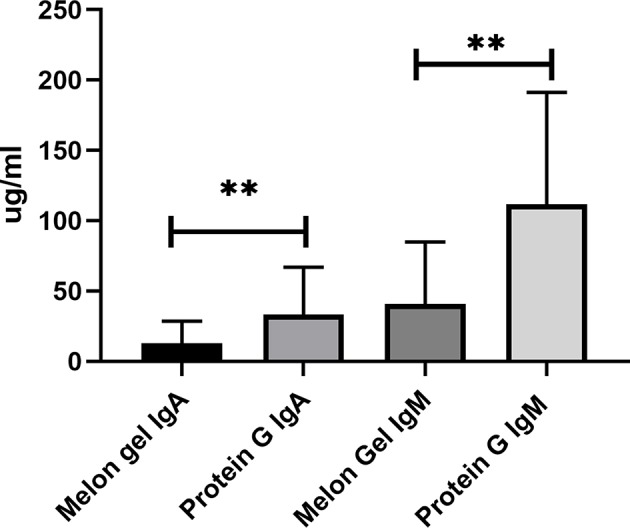
Median + IQR of concentration of non-IgG immunoglobulins (IgA and IgM) observed in Melon Gel vs. Protein G purification, n = 8.